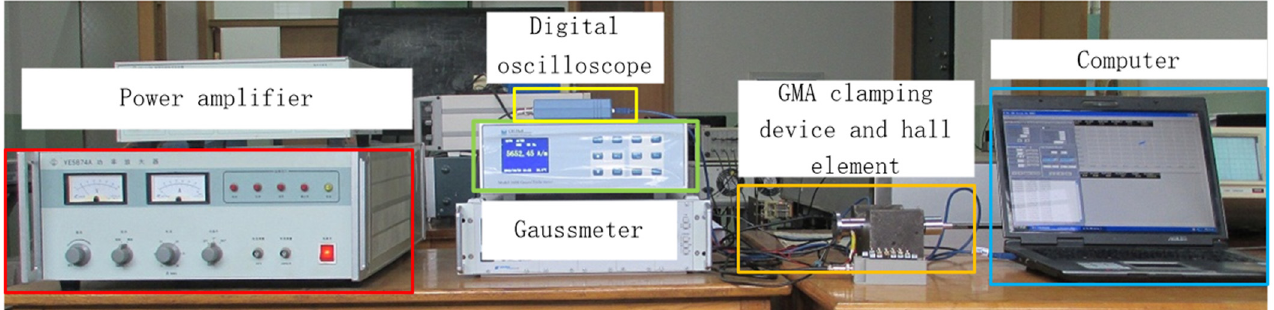
Figure 19. Magnetic field intensity testing system.